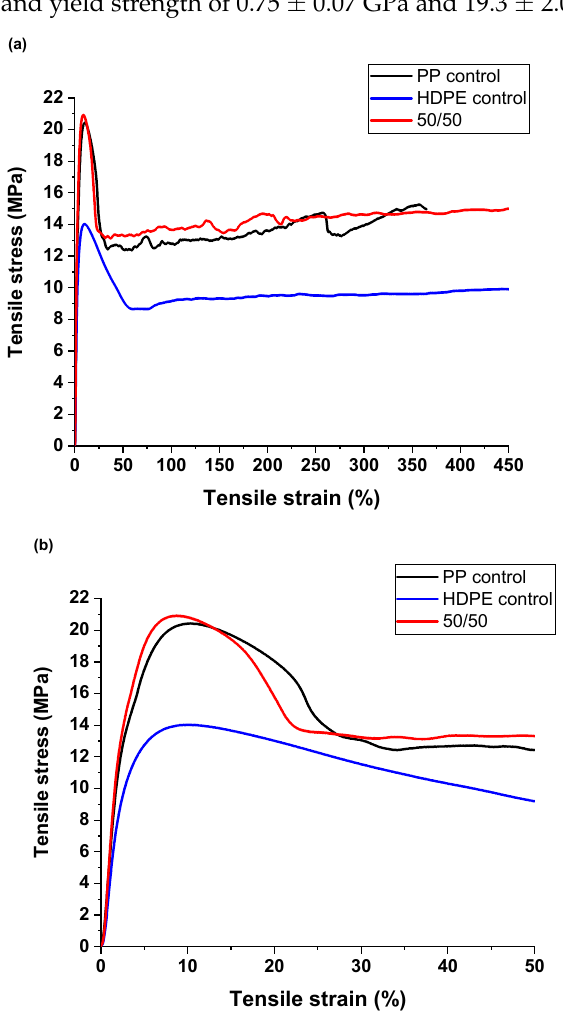
Figure 5. Typical stress–strain curves of unoriented PP control tape, HDPE control tape and 50/50 PP/HDPE tape tested at 100%/min, room temperature; ( a ) overall; ( b ) enhanced 0–5% strain region.